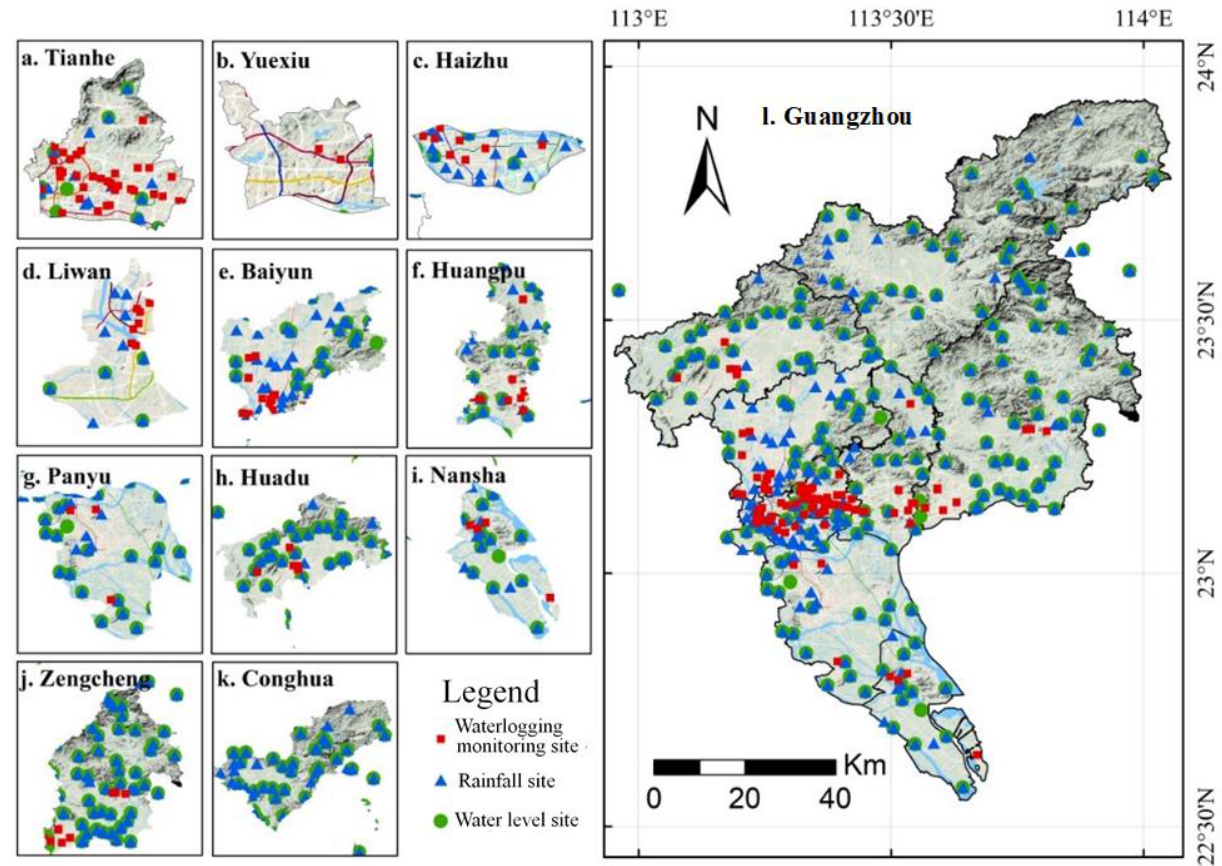
Figure 1. Monitoring sites in the administration areas of Guangzhou city ( l ), Tianhe district ( a ), Yuexiu district ( b ), Haizhu district ( c ), Liwan district ( d ), Baiyun district ( e ), Huangpu district ( f ), Panyu district ( g ), Huadu district ( h ), Nansha district ( i ), Zengcheng district ( j ), and Conghua district ( k ).